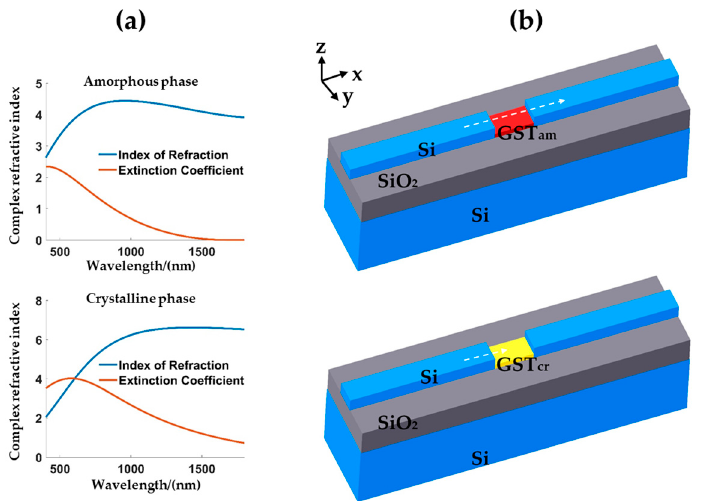
Figure 1. ( a ) Complex refractive index as a function of wavelength for amorphous and crystalline phases of GST material. ( b ) Schematic structure of the device showing ON-state and OFF-state optical transmissions.